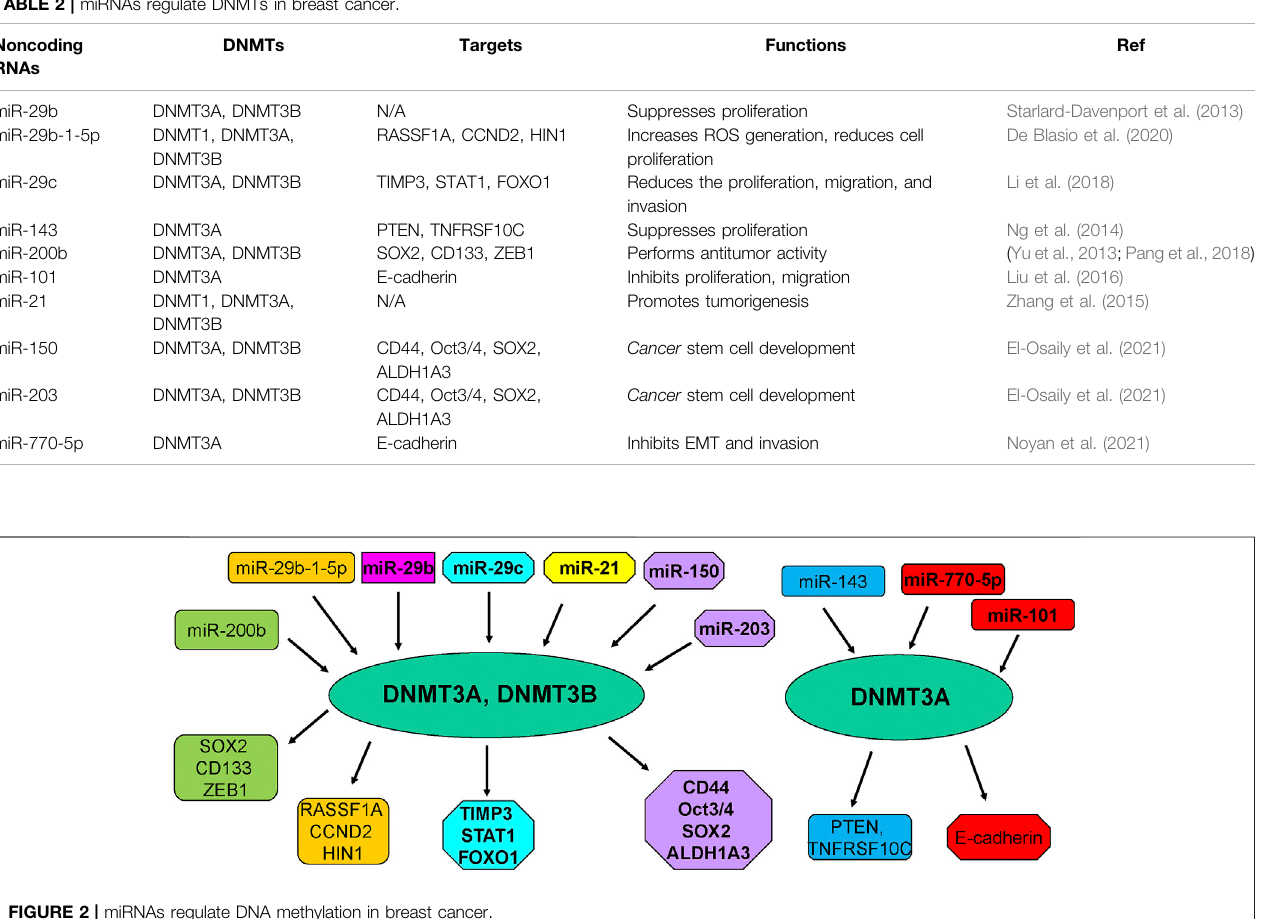
FIGURE 2 | miRNAs regulate DNA methylation in breast